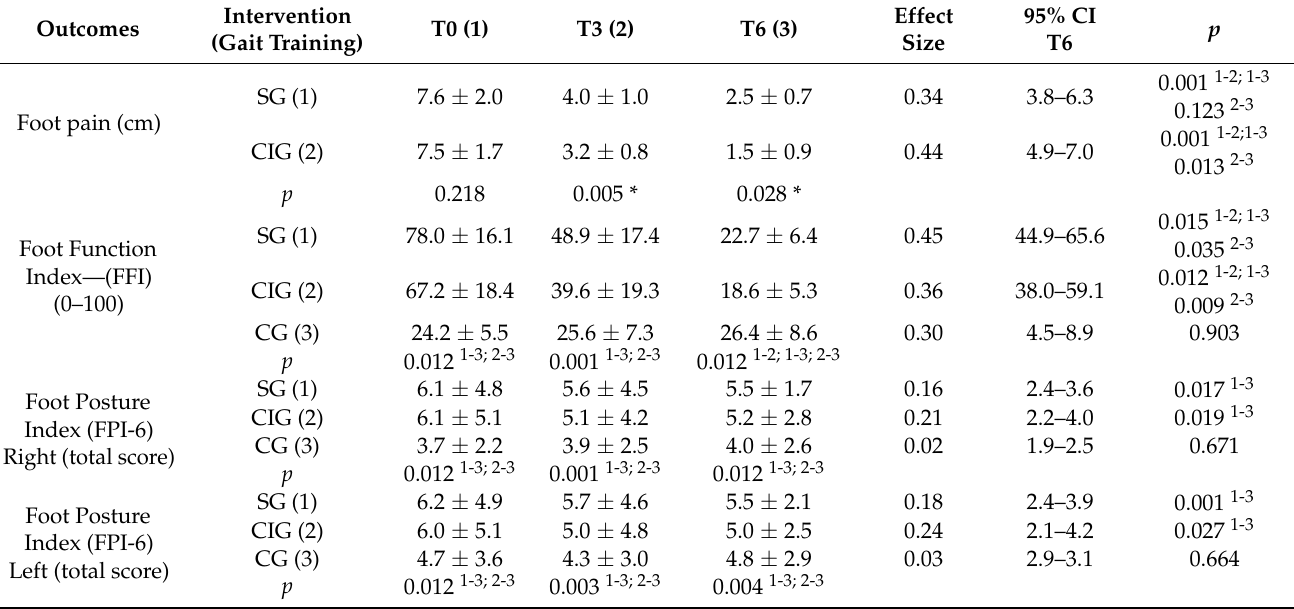
Table 2. Pain, function, and posture of the feet in the inter-group comparisons: minimalist shoe (SG), custom insole (CIG), and control group (CG), and interventions: T0 (baseline) and after T3 and T6 months of intervention in women with plantar fasciitis (PF).